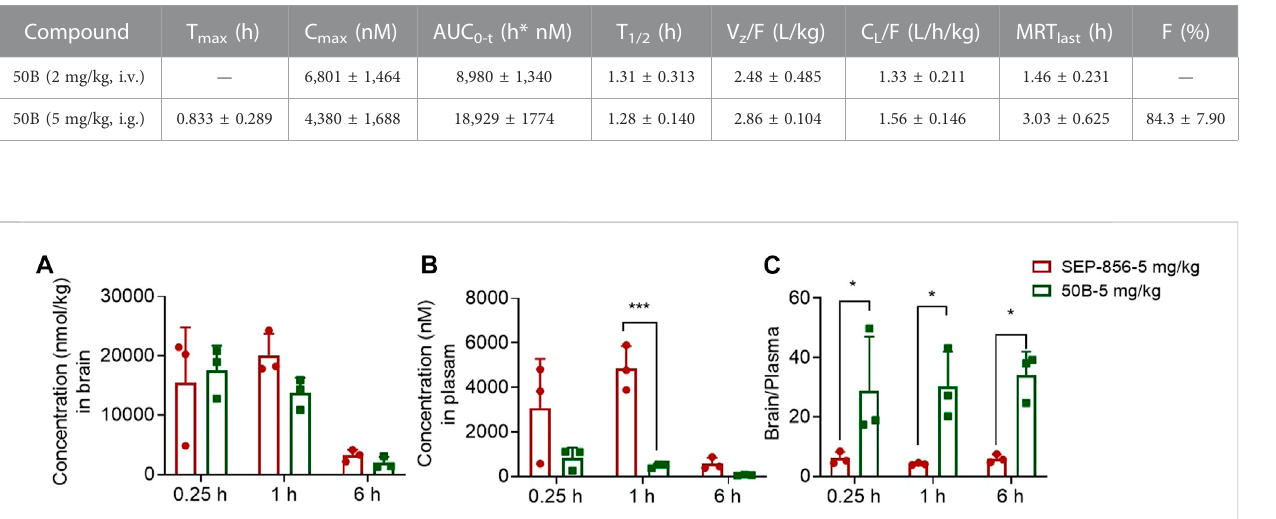
FIGURE 4 Concentrations of 50B and SEP-856 in brain and plasma, as determined by LC-MS/MS. (A) Concentration – time pro fi les of 50B and SEP-856 in the brain. (B) Concentration – time pro fi les of 50B and SEP-856 in plasma. (C) Concentration ratio of 50B and SEP-856 in the brain to plasma. Results are expressed as mean ± SD ( n = 3). * p < 0.05 and *** p <